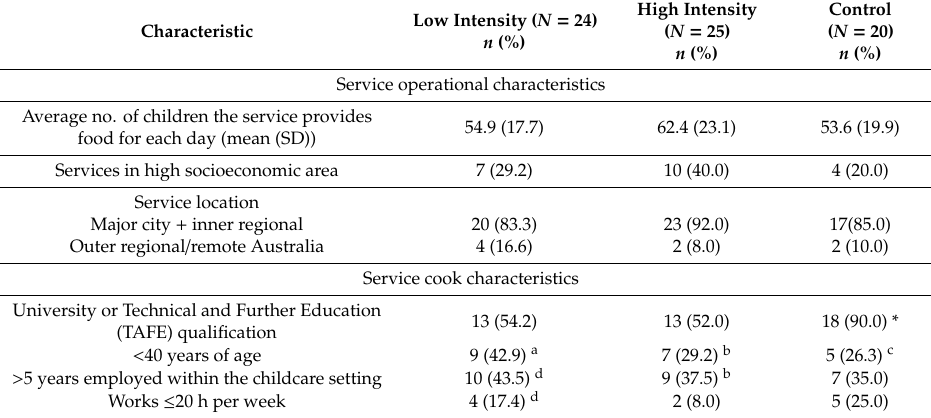
Control High Intensity Low Intensity ( N = 24) ( N = 20) ( N = 25) n (%) n (%) n (%) Service operational characteristics